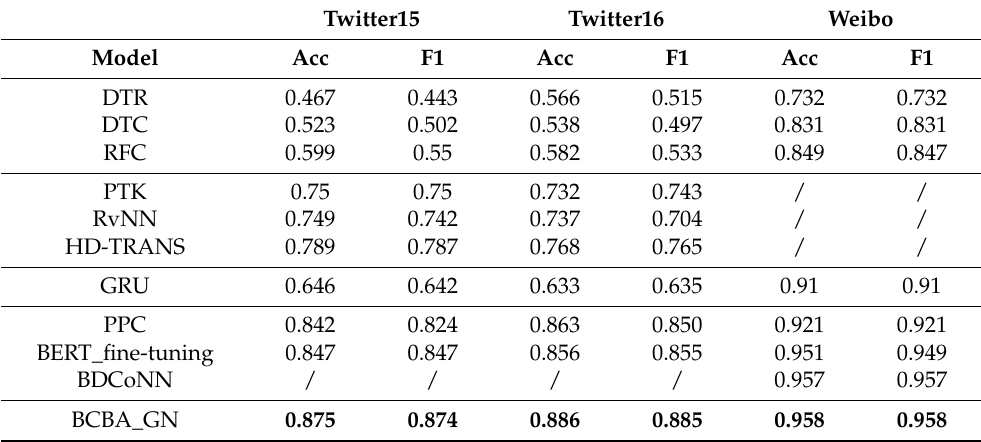
Table 4. Comparative experimental